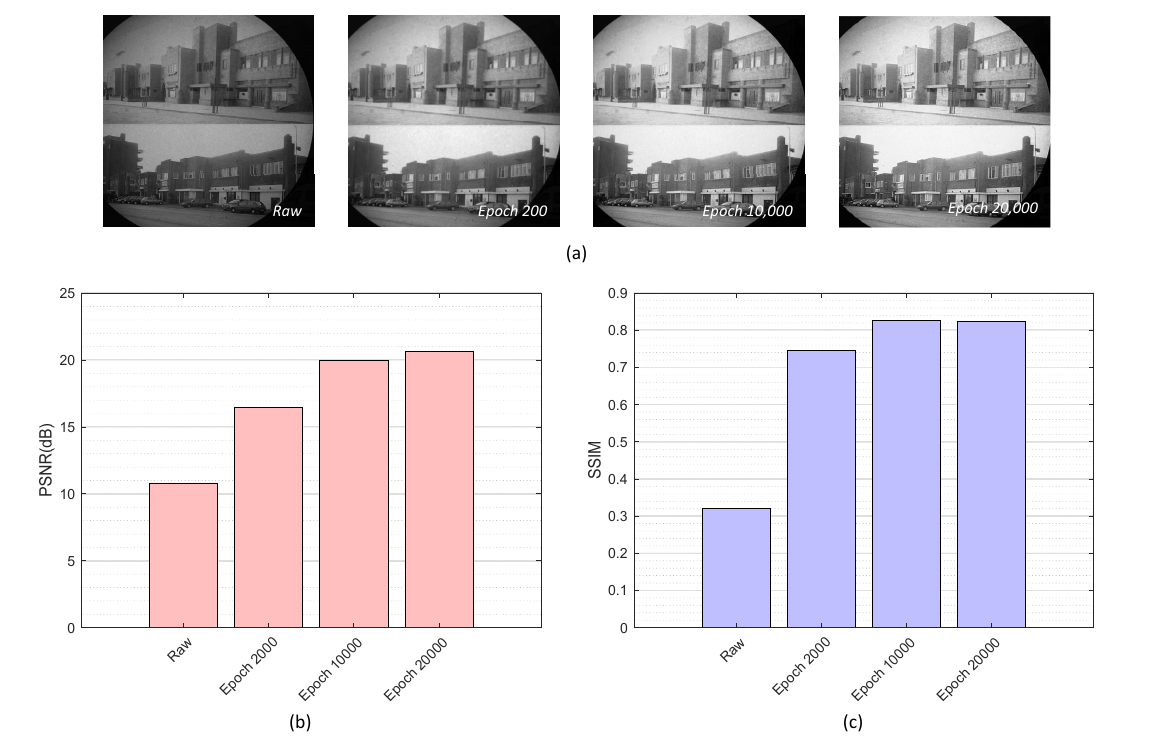
Figures Figure 4. ( a ) Restored images for various training epochs, ( b ) PSNR according to the increment of training epoch, ( c ) SSIM according to the increment of training epoch.